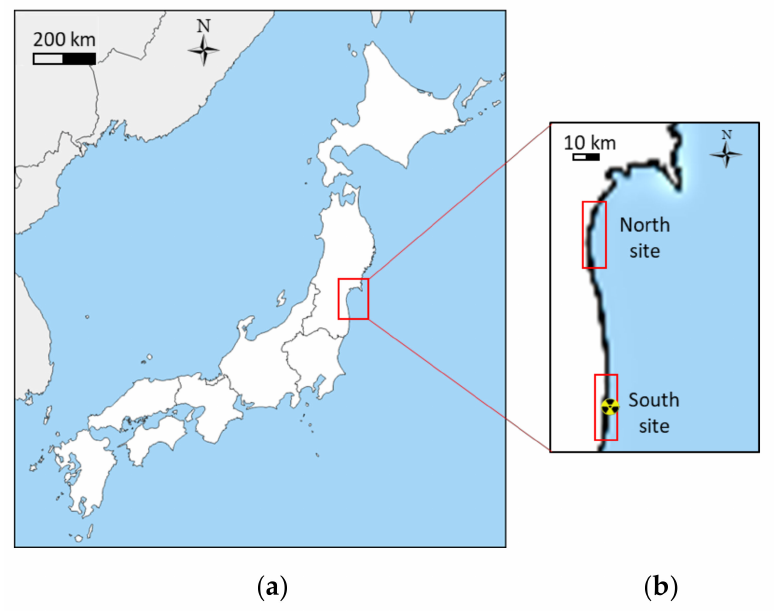
Figure 1. Regional ( a ) and local ( b ) study area in Japan. The specific areas that were covered by the satellite images of this study are indicated by a red box. The Fukushima Daiichi Nuclear Power Plant is marked by the nuclear symbol (south of the